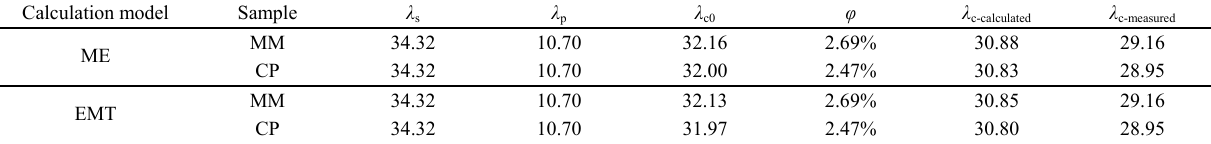
Table 3 A comparison between the calculated and measured thermal conductivities of Y 2 O 3 –Al 2 O 3 system Calculation